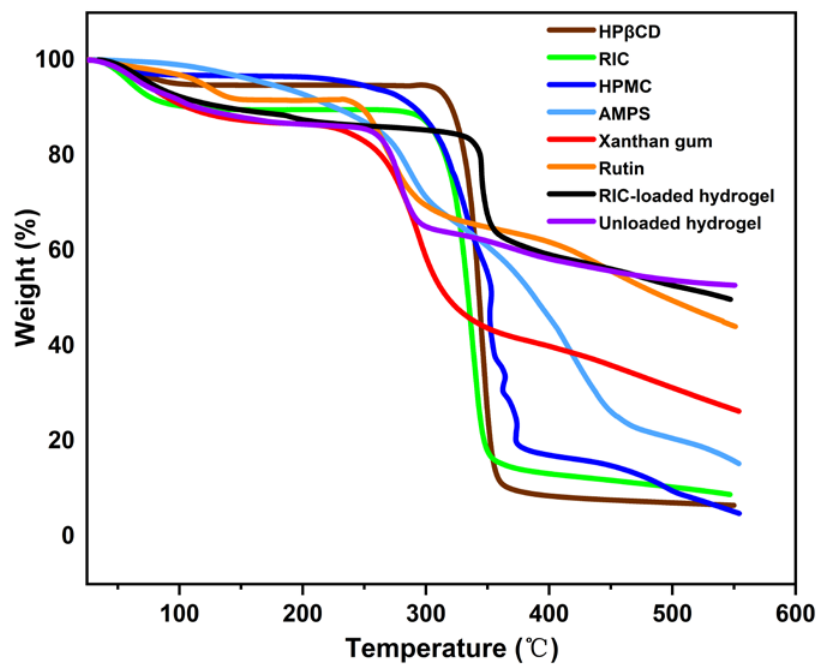
Figure 3. TGA analysis of HP- β CD, rutin, HPMC, XG, AMPS, RIC , unloaded and RIC -loaded hy- drogels.